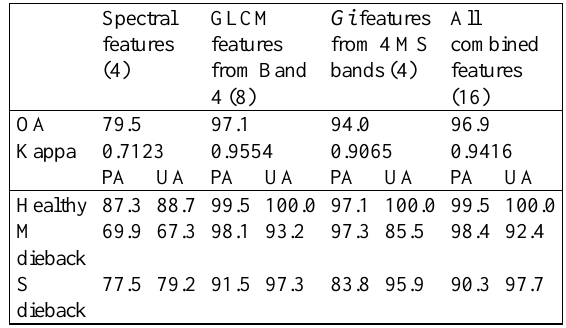
Table 1. Confusion matrices and RF classification accuracies using four spectral bands (reflectances), eight GLCM textures (calculated from Band 4 using the window size of 13 × 13 and direction 45°), four Gi features (calculated from the four MS bands using distance value of 5 and Queen’s neighborhood rule), and four spectral, eight GLCM, and four Gi combined features together. A number in parenthesis was the number of total features used. OA%: overall accuracy; PA%: Producer’s accuracy; UA%: User’s accuracy; M: medium; S: severe. Figure 2. Illustration of the effects of the Gi distance thresholds (unit: pixel) and neighborhood rules on the RF classification accuracies